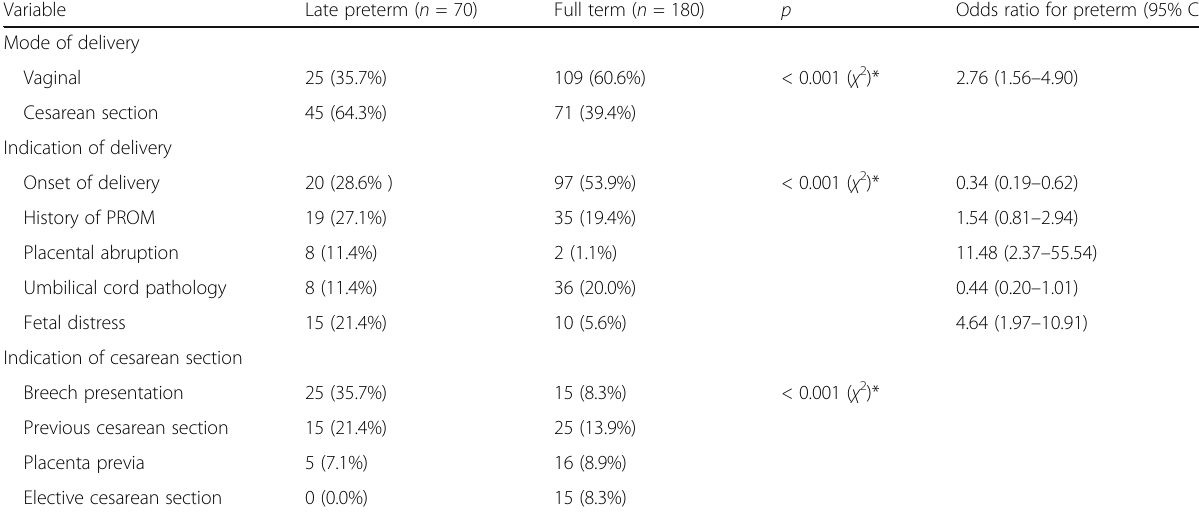
Table 2 Delivery characteristics of mothers of the studied groups ( n = 250)